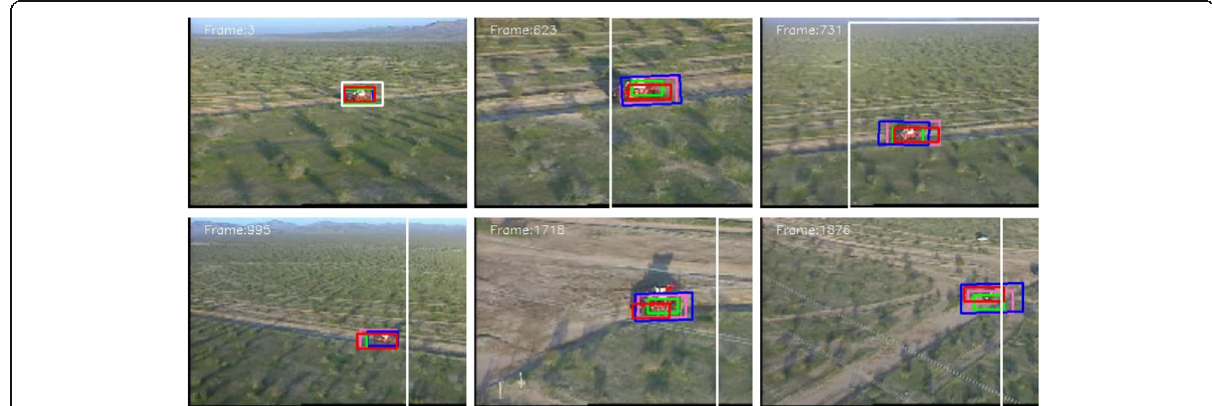
Fig. 21 The tracking results for the video “ RedTeam ” using CAM-Shift (white), PF (blue), VAPF (green), M-PF (pink), and the proposed tracker (red). Particle number N = 200